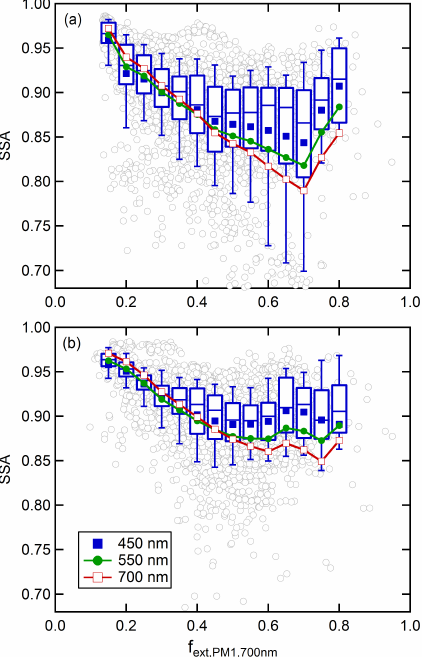
Figure 4. Relationship between the PM 10 SSA and the PM 1 frac- tion of extinction at 700nm, f ext,PM , for the (a) T0 and 1 , 700 (b) T1 sites. The individual data points (gray circles) are shown for the SSA PM at 450nm along with a box-and-whisker plot 10 binned by f ext,PM . For the SSA PM at 550nm (green line) 10 1 , 700 and 700nm (red line) only the mean, binned values are